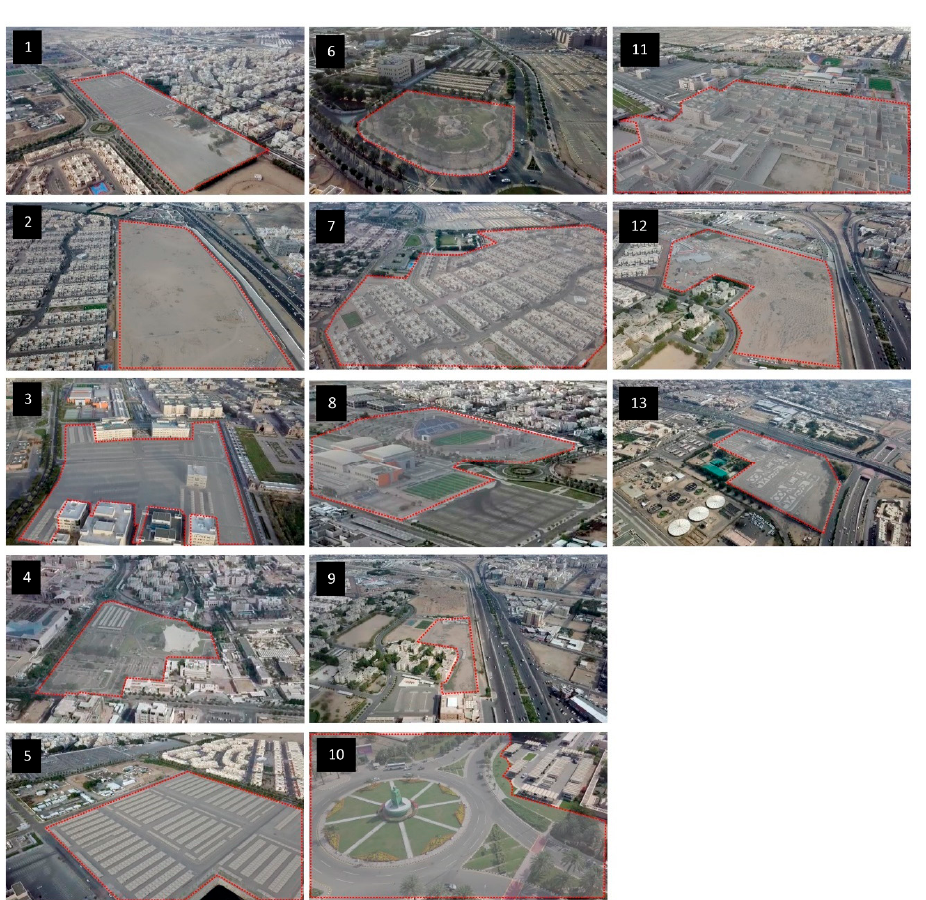
Figure 2. Orientation photos (site location numbers correspond to the orientation map, Figure